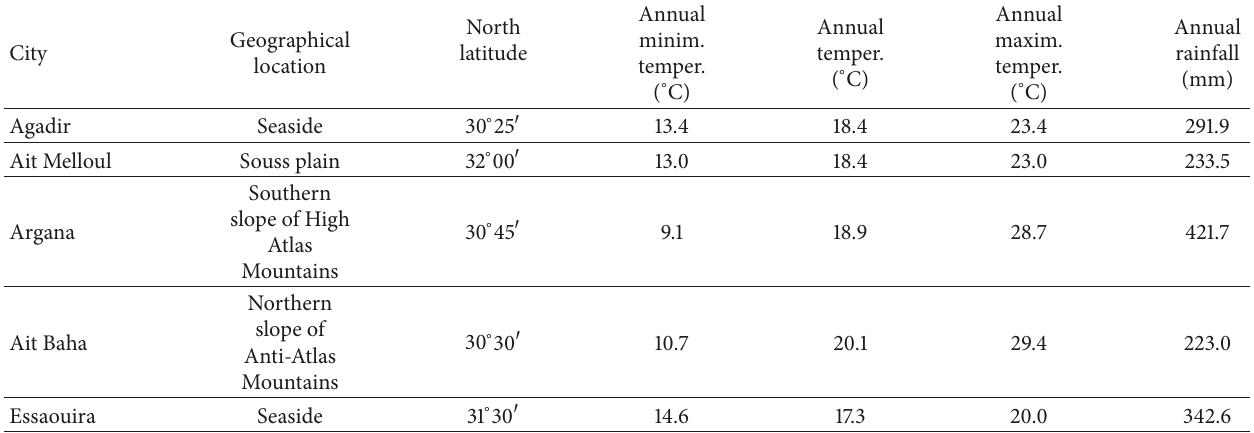
Table 1: Climatic characteristics of area of origin of the argan tree (elaborated by the authors based on [14]).